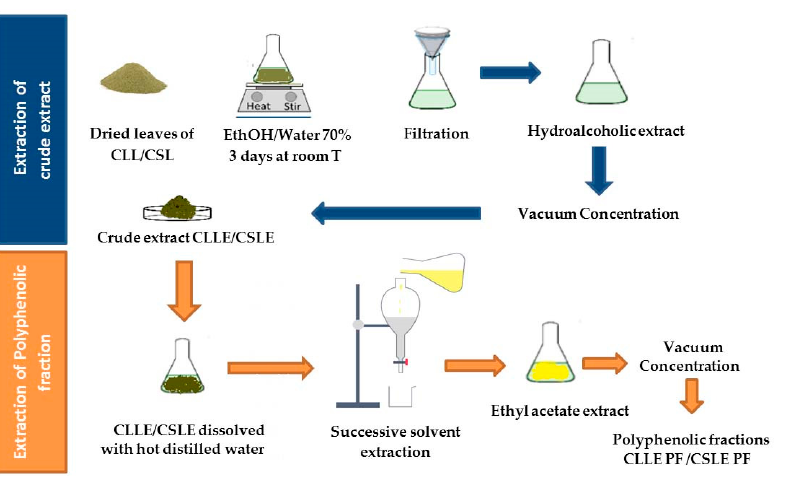
Figure 2. Extraction process of crude extracts and polyphenolic fractions of C. laurifolius L. and C. salviifolius L.